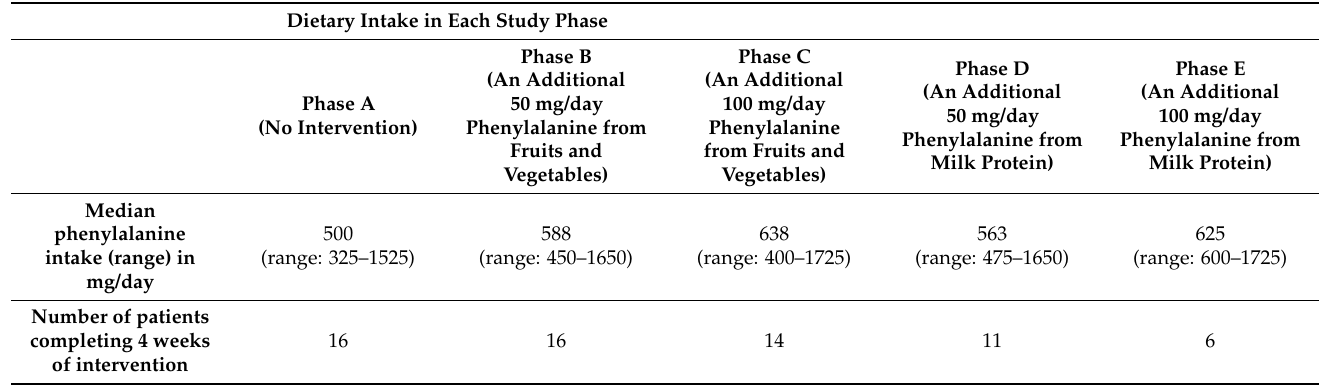
Table 6. Phenylalanine intake (mg/day) in each phase of the